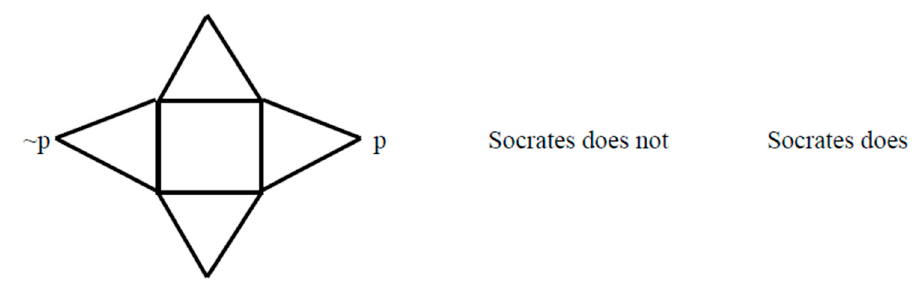
Figure 8. The octagon of bad behavior.